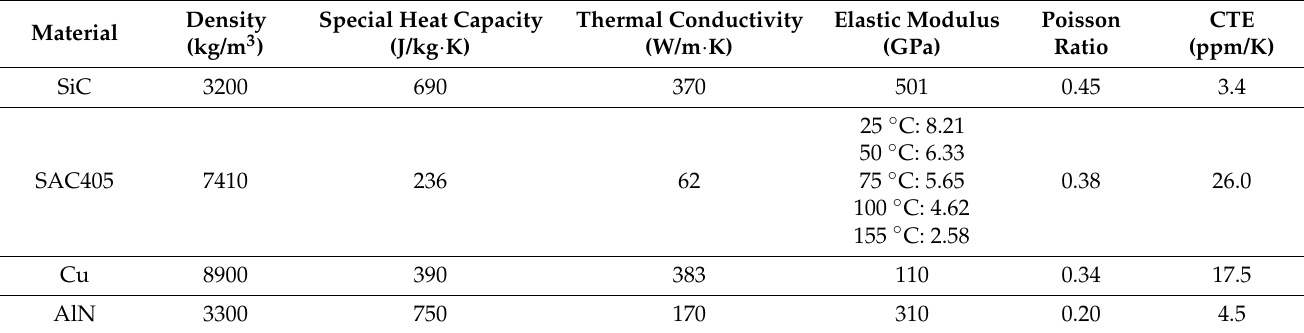
Table 1. Material properties for the FEM models.